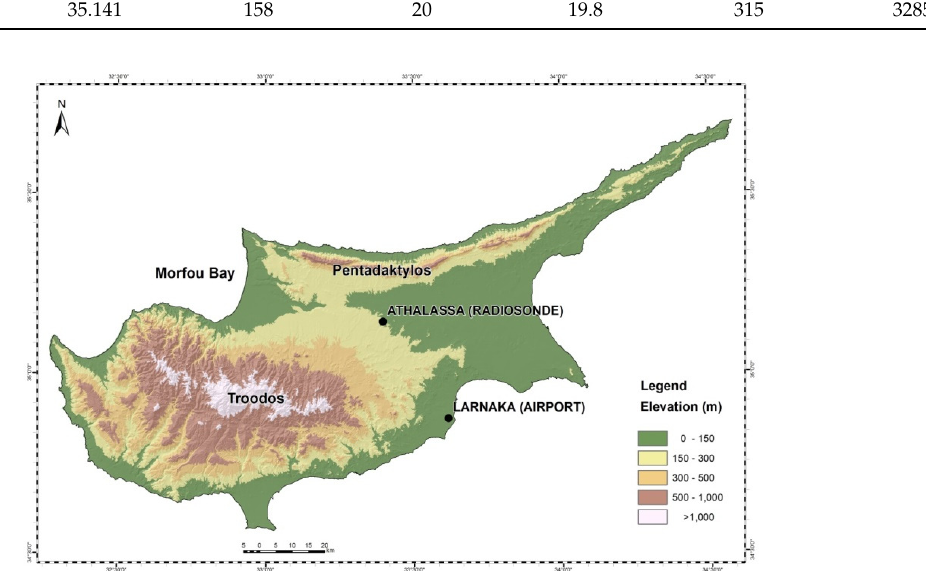
Table 1. Station’s coordinates and mean annual air temperature ( T a ), mean annual precipitation (Prec) and mean annual number of hours of sunshine duration. Long. (E) Station (deg.)